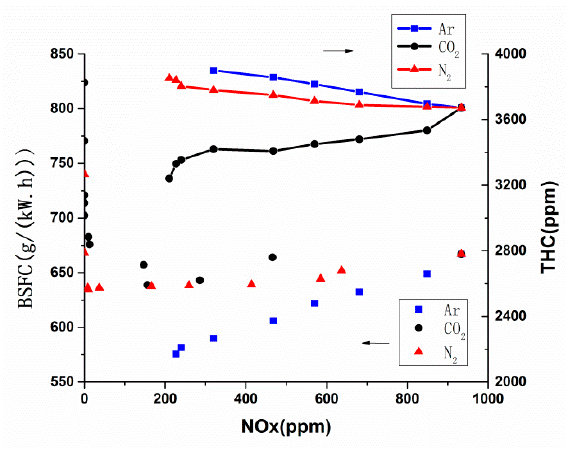
Figure 15. Variation in methanol consumption and THC emissions vs. NOx emissions.